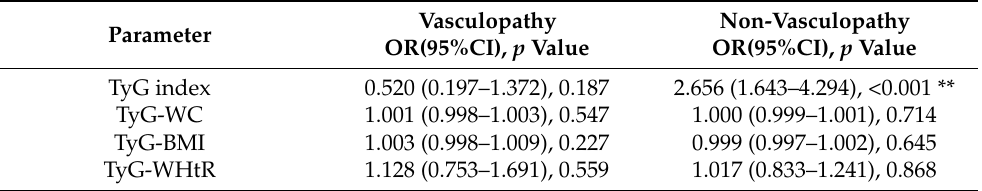
Table 4. Vasculopathy subgroup analysis of the associations between the TyG index and dia- betic retinopathy.